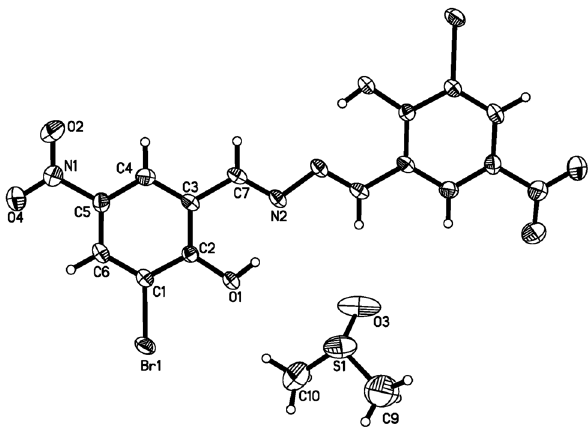
Table 1 contains crystallographic data and Table 2 contains the list of the atoms including atomic coordinates